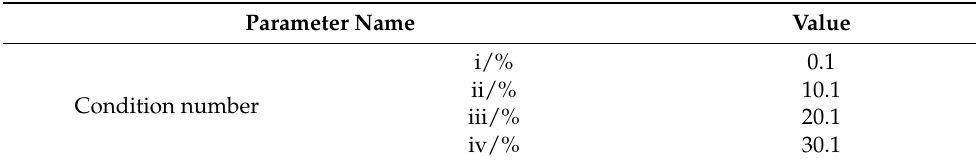
Table 5. System air content under different working